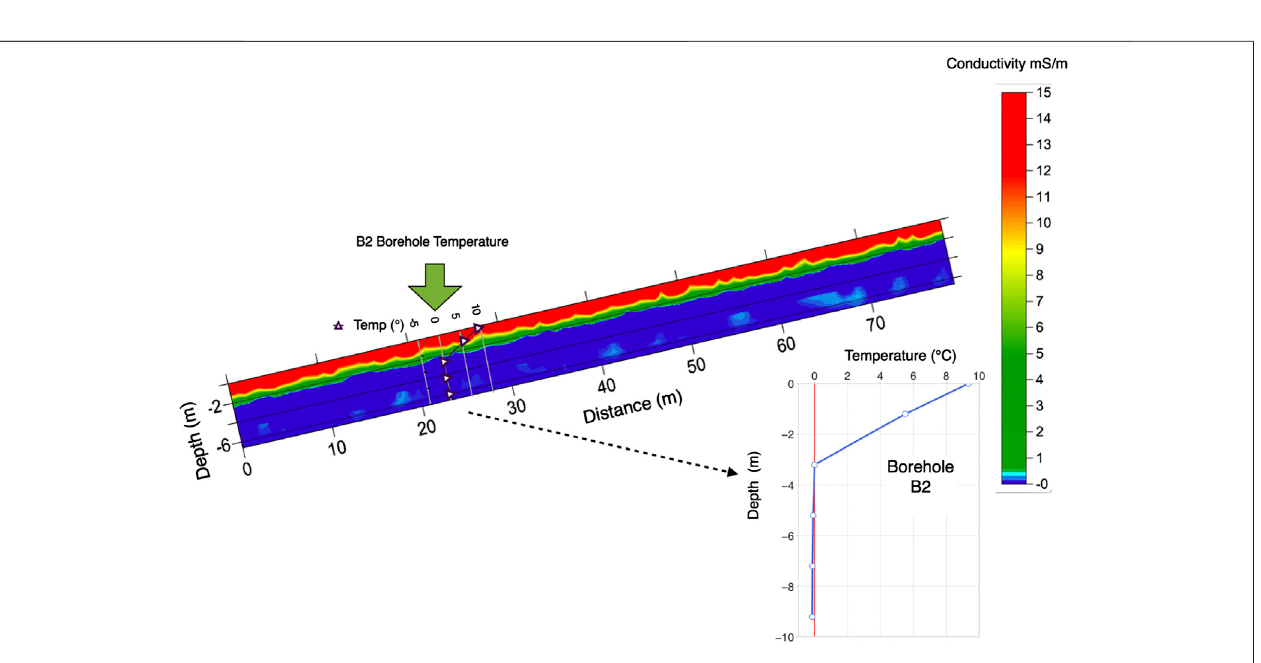
Frontiers in Earth Science |